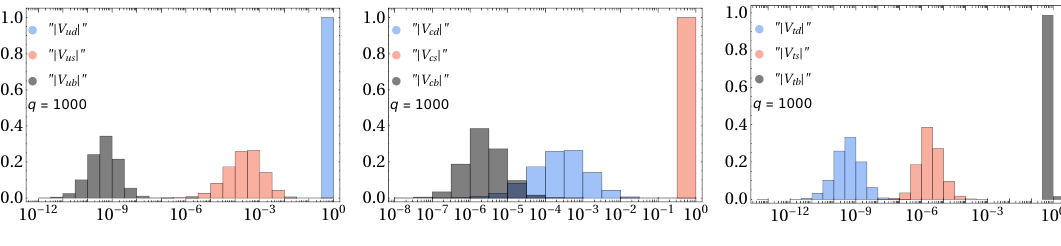
Figure 9 . The CKM elements that would be obtained from coupled FN chains for the case of a very large q = 1000. This shows the hierarchy between the would-be CKM matrix elements more